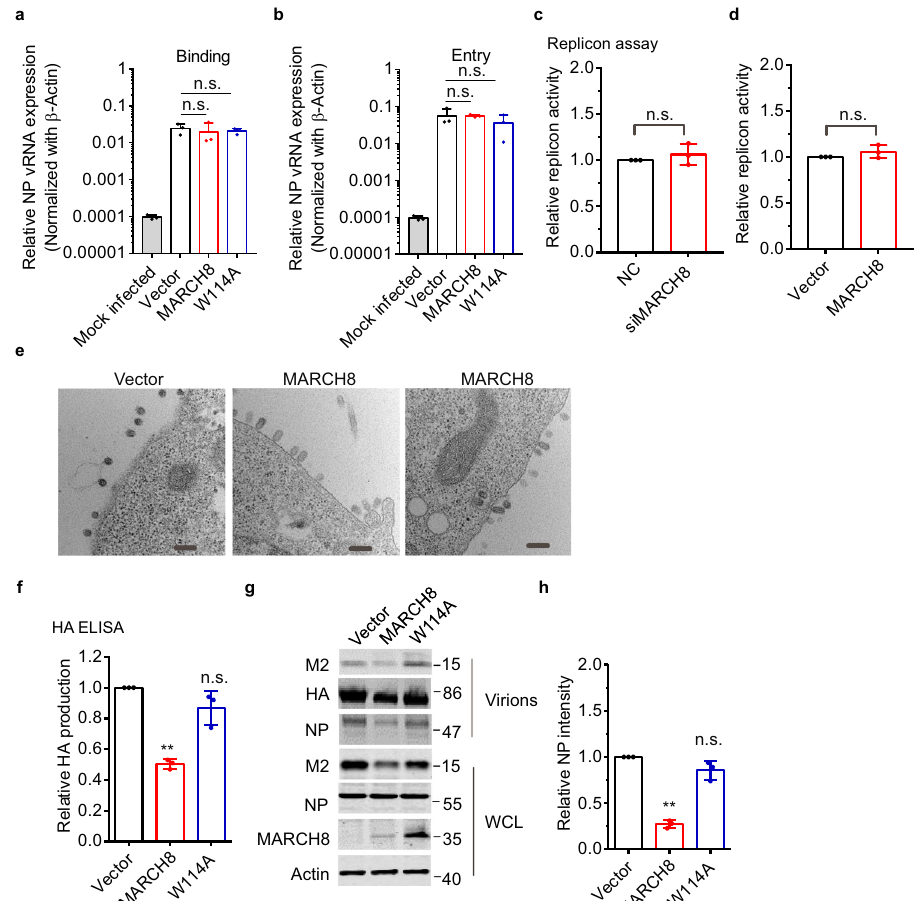
Fig. 4 MARCH8 reduces IAV release. a , b HEK293T cells were transfected with vector, MARCH8 or W114A. Cells were incubated with WSN virus (MOI = 5) at 4°C for 1h ( a ) or then allowed to internalize bound IAV by incubation at 37°C for another 30min before adding exogenous NA to remove cell-surface virions. Viral binding or entry was assessed by determining the viral copy number in cell lysates by quantitative real-time PCR. c , d HEK293T cells were co- transfected with pPolI-Luc and expression plasmids containing viral PB1, PB2, PA, or NP of H1N1 along with control (NC) or MARCH8 siRNAs ( c ), MARCH8 or vector ( d ). Renilla luciferase was used as an internal control. Luciferase activity was determined at 24h post transfection. e HEK293T cells transfected with MARCH8 or vector were infected with an MOI of 5 of WSN virus for 10h and thin sections were analyzed by electron microscopy. The scale bars indicate 200 nm. f – h HEK293T cells were transfected with vector, MARCH8 or W114A. Cells were infected with WSN virus at a MOI of 0.2. At 24h post infection, HA in the supernatants was determined by ELISA ( f ), and viral protein expression in cell lysates and the released virus particles were detected by western blotting ( g ). Quantitation of released NP was shown in ( h ). Data shown are the mean±SD ( n = three independent experiments). ** P <0.001, n.s., nonsigni fi cant, unpaired two-tailed Student t -test, without any adjustments for multiple